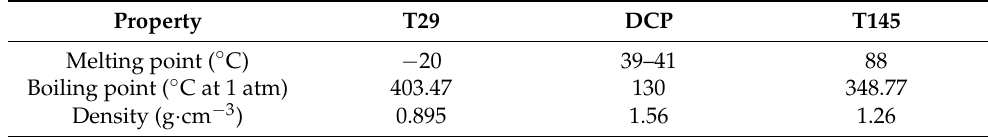
Figure 1. Chemical structure of organic peroxides used as cross-linking agents: ( a ) T29, ( b ) DCP, and ( c ) T145. Table 1. Physical properties of organic peroxides.